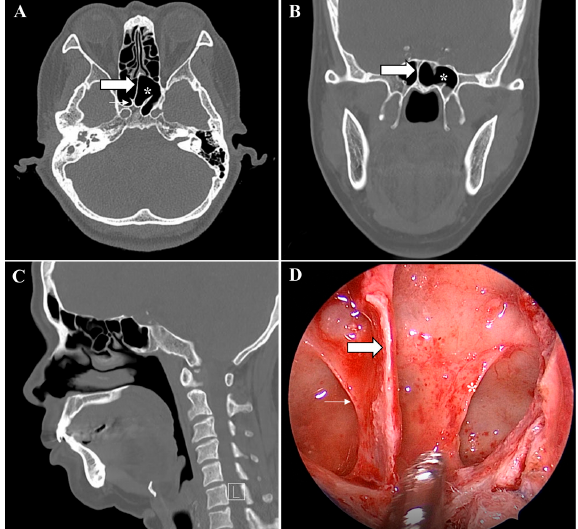
Figure 4. Incomplete pseudoclivus and intersphenoid sinus septum. Non-enhanced preoperative paranasal sinus computed tomography scan and the endoscopic view of the incomplete right pseu- doclivus (small arrow), the right vertical intersphenoid sinus septation (large arrow), and the right ridge (*): ( A ) PNS CT axial, ( B ) coronal, ( C ) sagittal, and ( D ) endoscopic view during EETSA-based surgery.